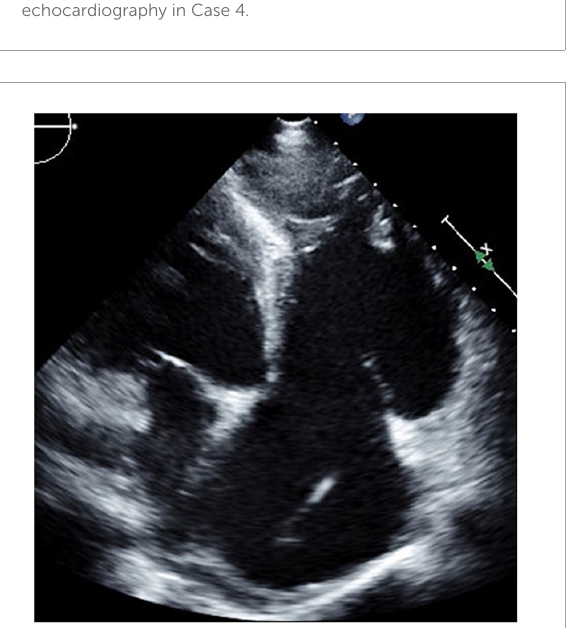
FIGURE5 Long-axis view at end-diastolic phase of transthoracic echocardiography in Case 3. Note that the right ventricle is much larger than the left ventricle, and the left ventricle is very small (end-diastolic dimension 31 mm).